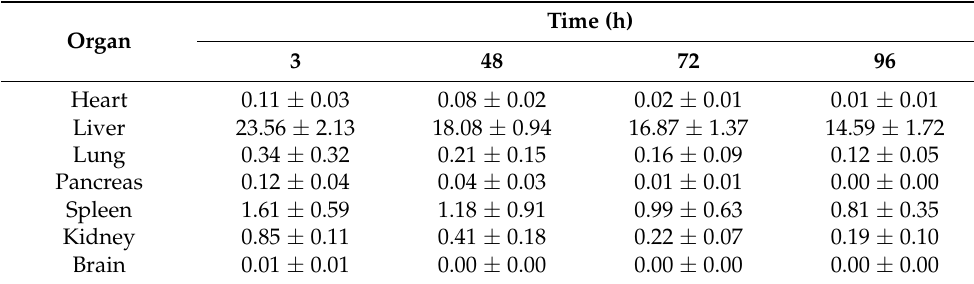
Table 1. Biodistribution (% injected dose) of 177 Lu 2 O 3 -iPSMA in CD1 mice at various time points (mean ± SD) ( n = 3) after intravenous injection.